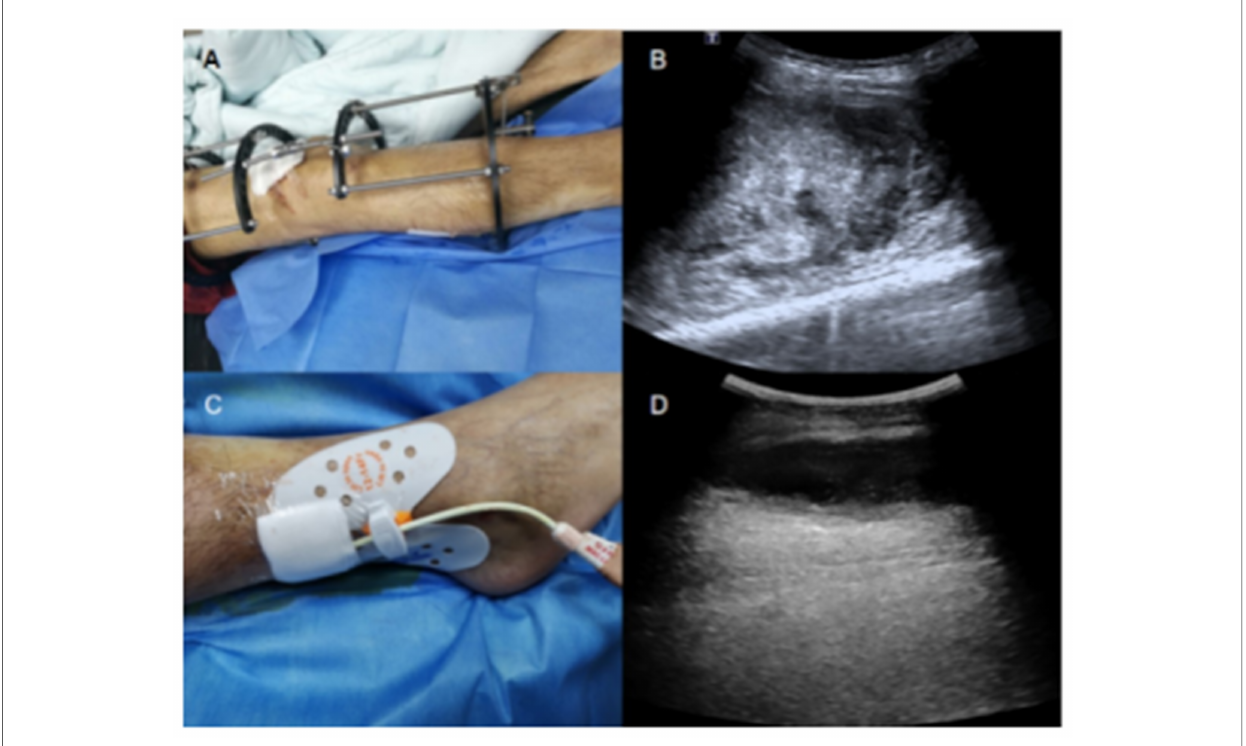
FIGURE 2 Ultrasound examination revealed a polycystic hematoma in the forearm fl exors (long axis section of the hematoma; ( A ). The hematoma was located between the median nerve (*), and radius-ulna (short axis section of the hematoma; ( B ). Three days after drainage and urokinase lavage, ultrasonography showed that the hematoma nearly disappeared ( C ). Hematoma did not recur at the 4-month follow-up after treatment ( D